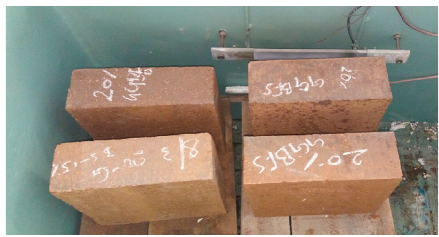
Figure 1: Curing of stabilized geopolymer mud blocks.